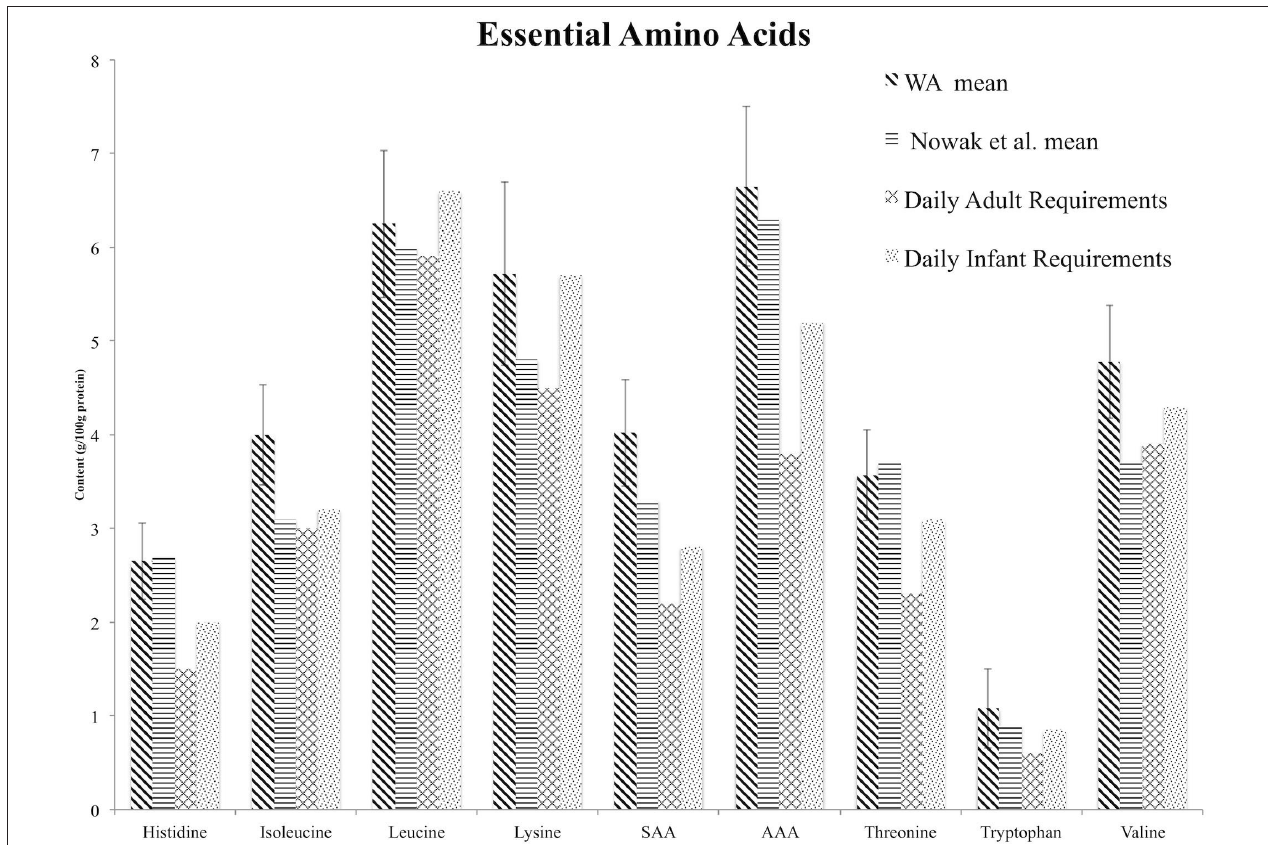
FIGURE 1 | Comparison of essential amino acid mean values from the Washington grown samples (WA Mean) reported with error bars representing one standard deviation, mean values reported in the review by Nowak et al. ( 37), and daily adult and infant essential amino acid requirements established by the World Health Organization (52). Differences among groups are not statistically significant. SAA, sulfur amino acids; AAA, aromatic amino acids.